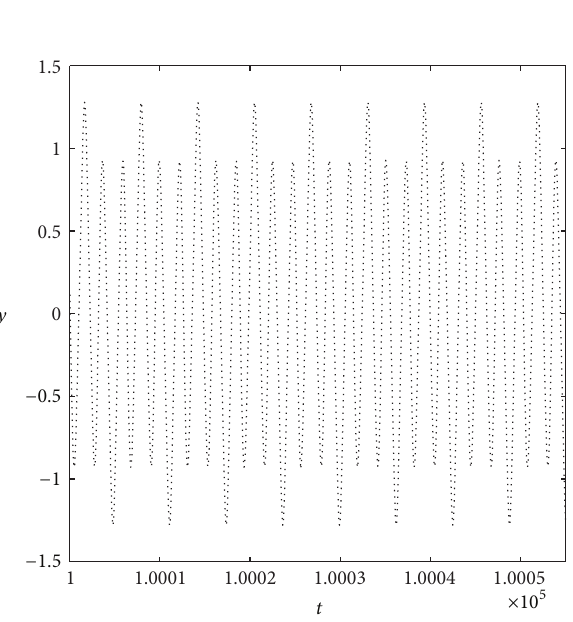
Figure 5: Phase portrait (𝑦, ̇𝑦) .